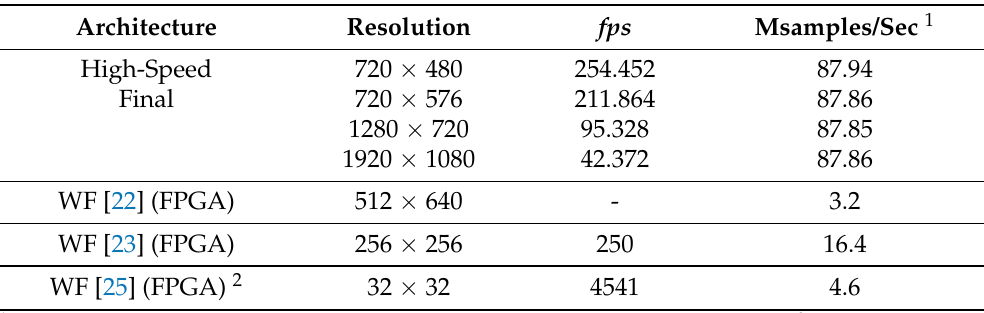
Table 4. Video sequences